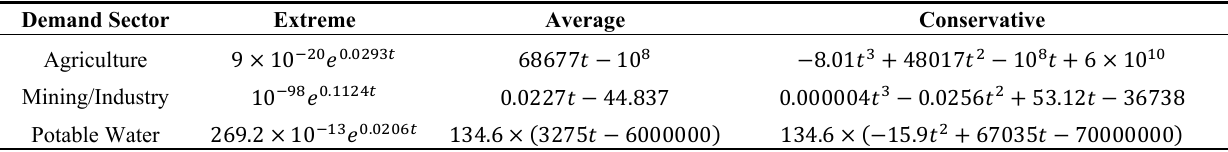
Table 5. Demand scenario future models where t is the calendar year; response variables are million hectares for agriculture, m 3 /s for mining/industry, and population for potable water.